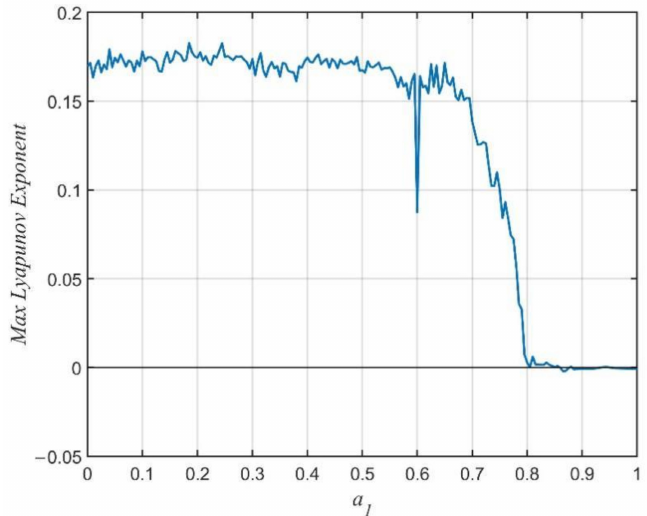
Figure 2. Maximum Lyapunov exponent of system (14) with a 1 varying from 0 to 1 for q = 0.95.